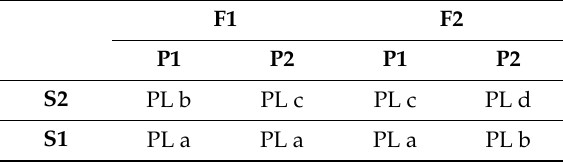
Table 8. Converted risk graph for low probability of occurrence of the hazardous event.